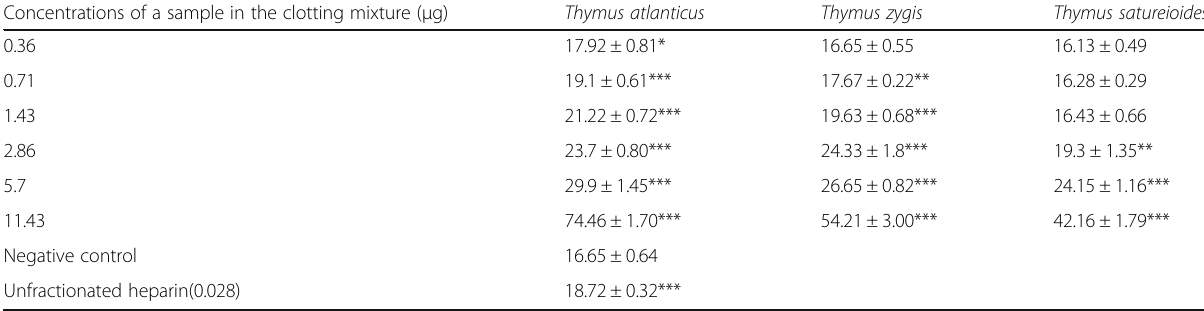
Table 5 In vitro thrombin time measurements of aqueous extracts in human pooled plasma Concentrations of a sample in the clotting mixture ( μ